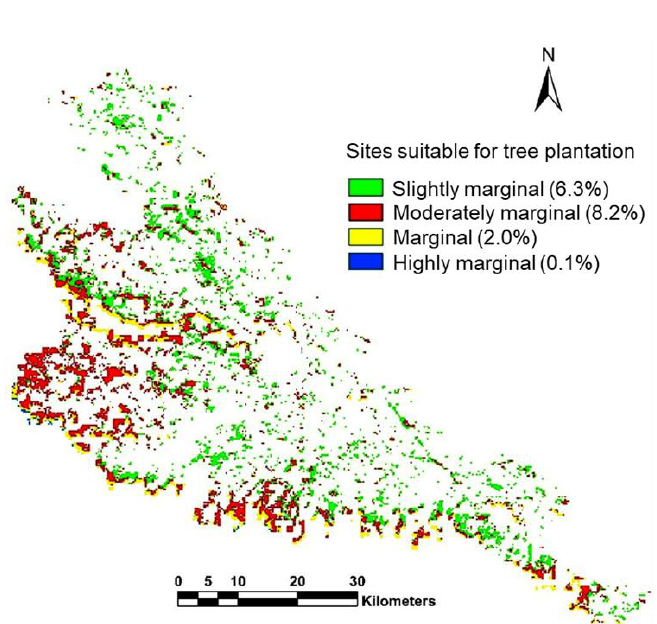
Figure 7. Marginal croplands with sufficient water availability for afforestation estimated based on land and water use data for 2003‒2009 . Source: [15] . land and water use data for 2003–2009. Source: